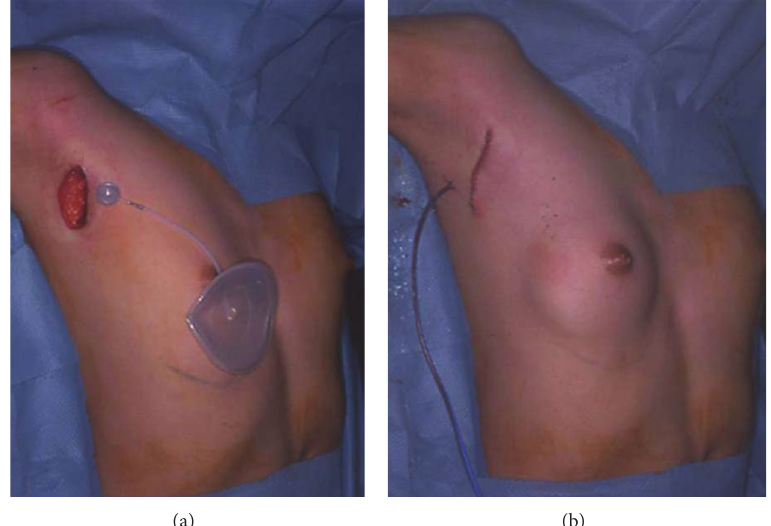
Figure 8: Intraoperative view: (a) Tissue expander was inserted submuscularly from the transaxial incision. (b) Initial volume of the tissue expander was 60mL.